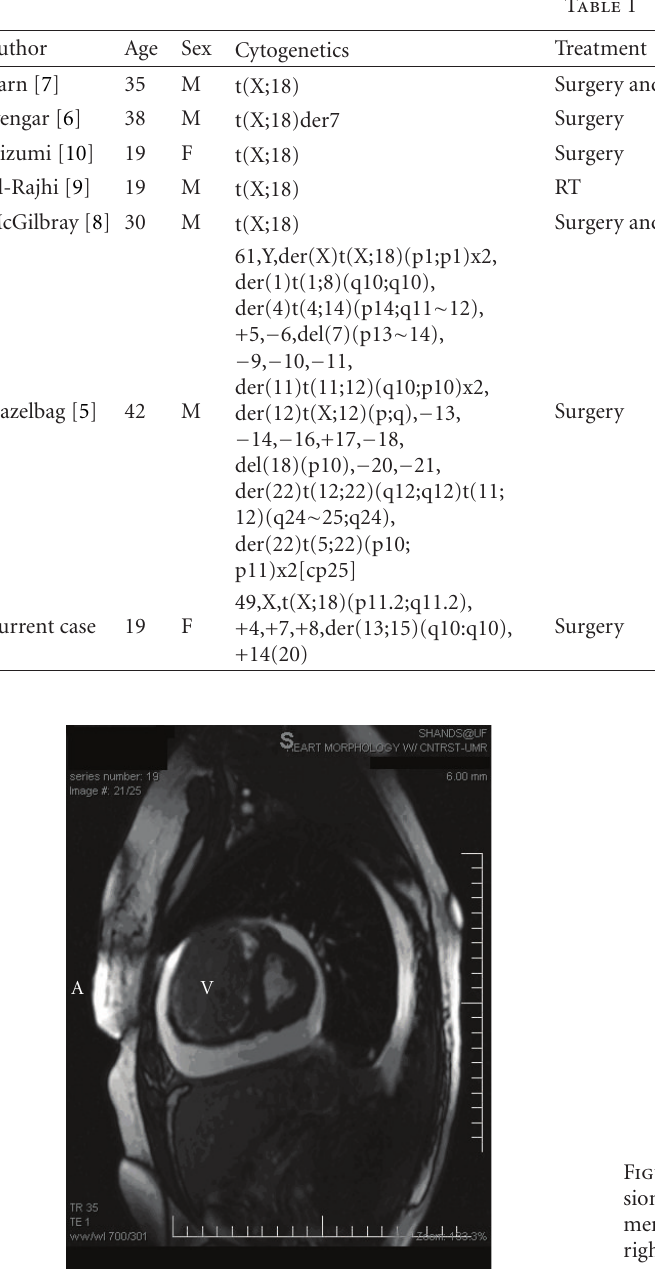
Figure 1: Short axis view shows a large tumor filling almost the entire right ventricle (V).